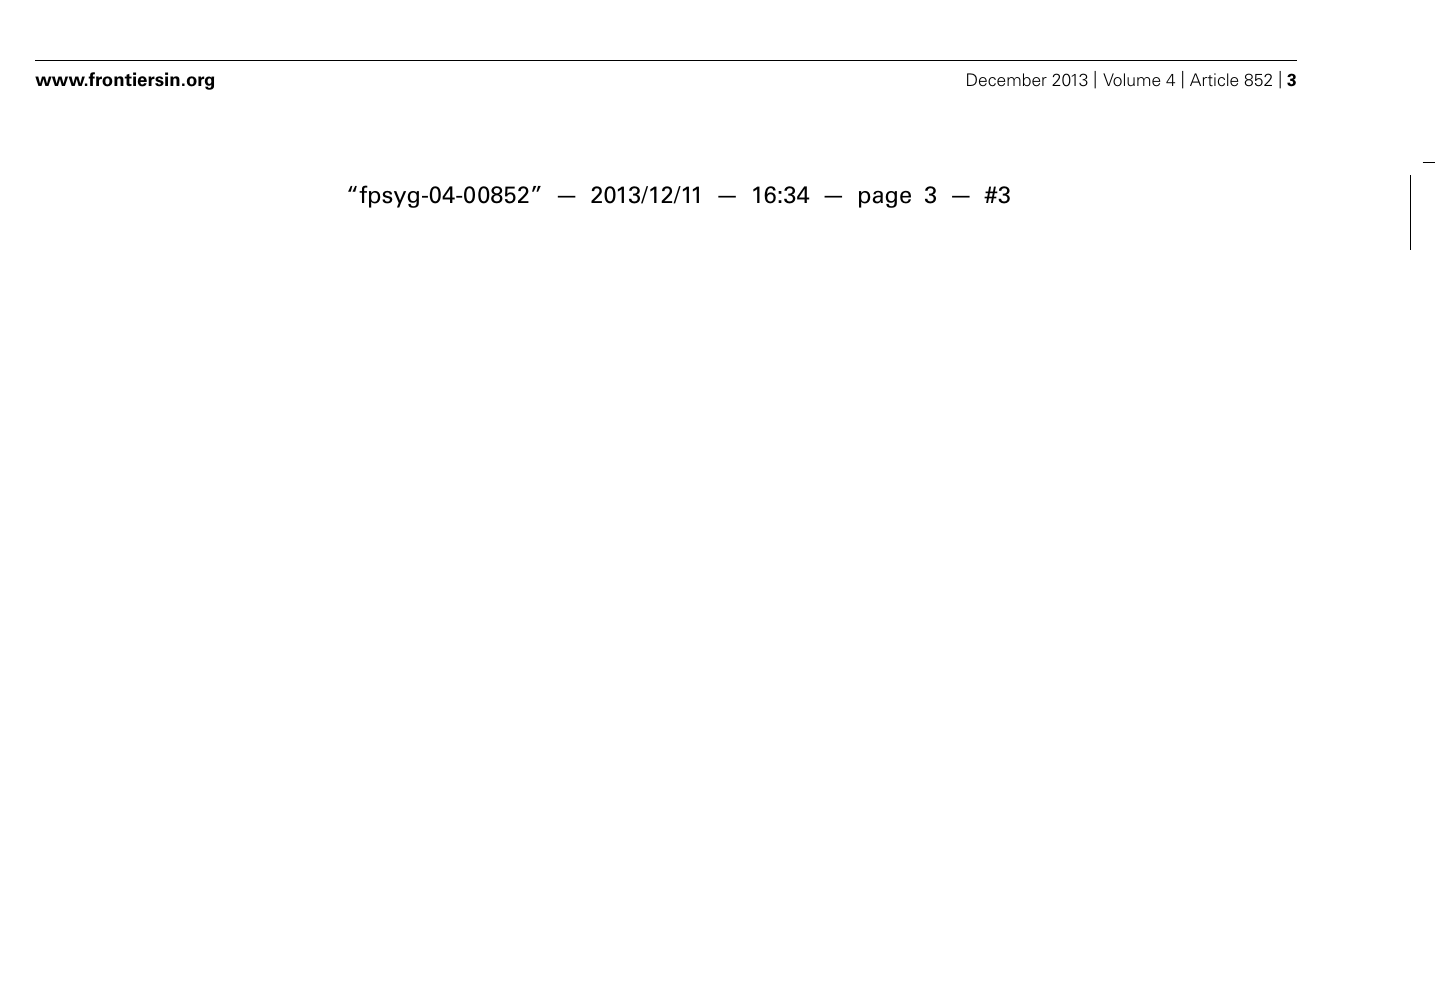
FIGURE 1 | Indoor environment in